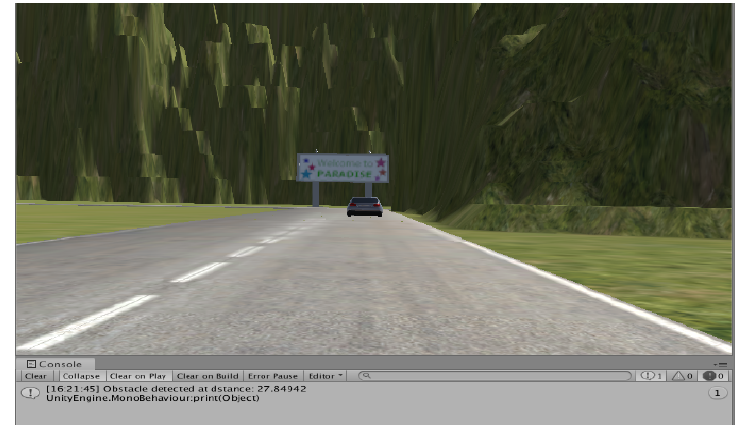
Figure 15. The first obstacle with limited visibility.